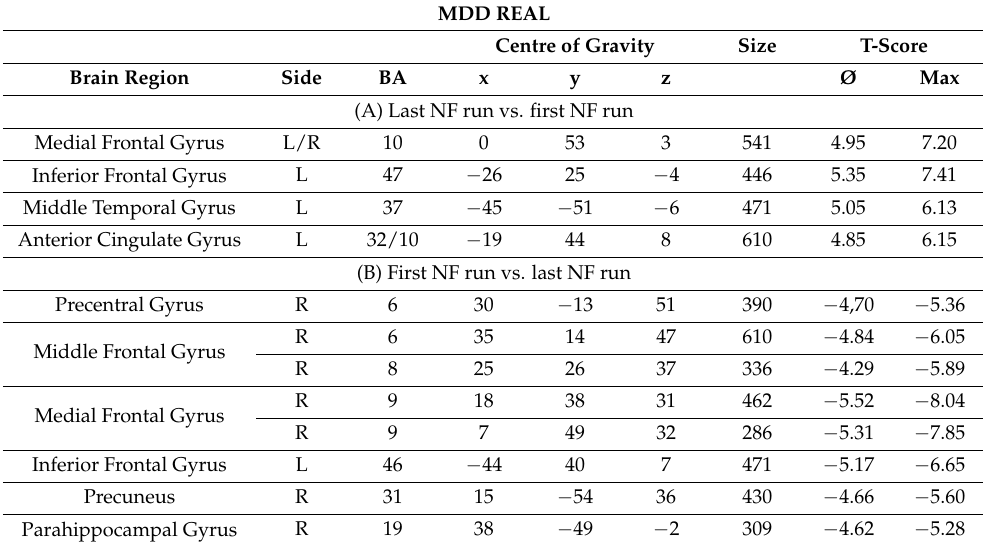
Table 7. Comparison of hemodynamic responses between the first and the last NF run (negative emotional- associated pictures minus neutral pictures; clusters of >30 voxels, q (FDR) < 0.001, T-score: 8 to − 8). MDD REAL Centre of Gravity